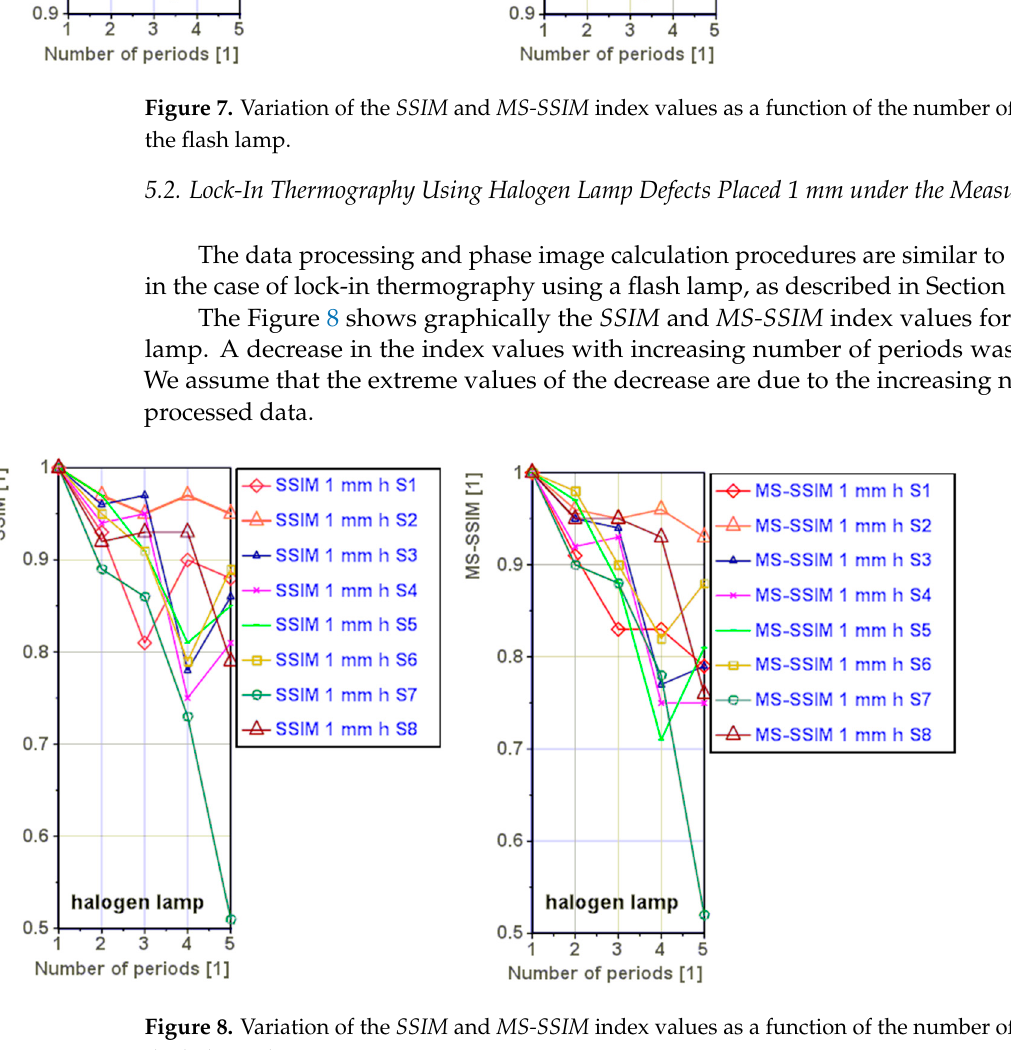
Figure 9. Phase images for the samples with the circular cross section defects. A halogen lamp was used as a source of excitation. S1–S4 denotes con fi guration of the circle holes.